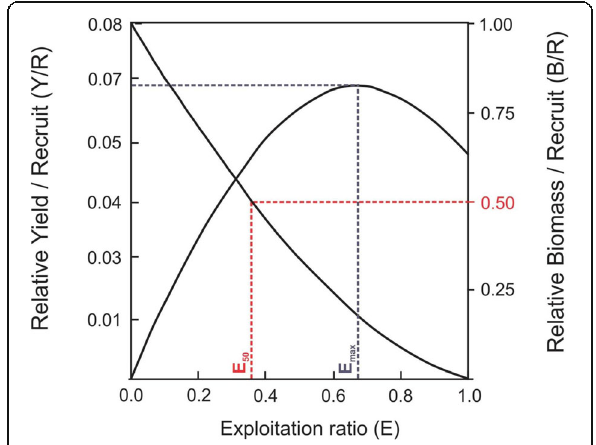
Fig. 5 Relative yield-per-recruit ( Y ′ / R ) and relative biomass-per-recruit ( B ′ /R ) analysis for Pachypterus khavalchor from the Panchaganga River, Maharashtra, India